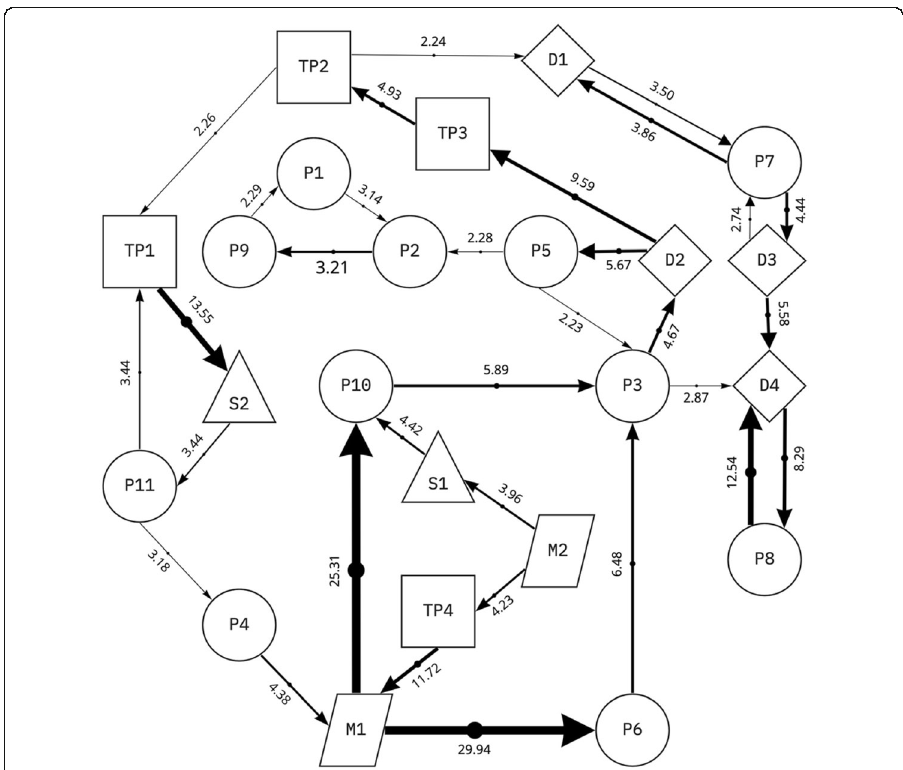
Fig. 7 Sequential patterns of learners ’ behaviors while performing the AR learning activities on Lines and